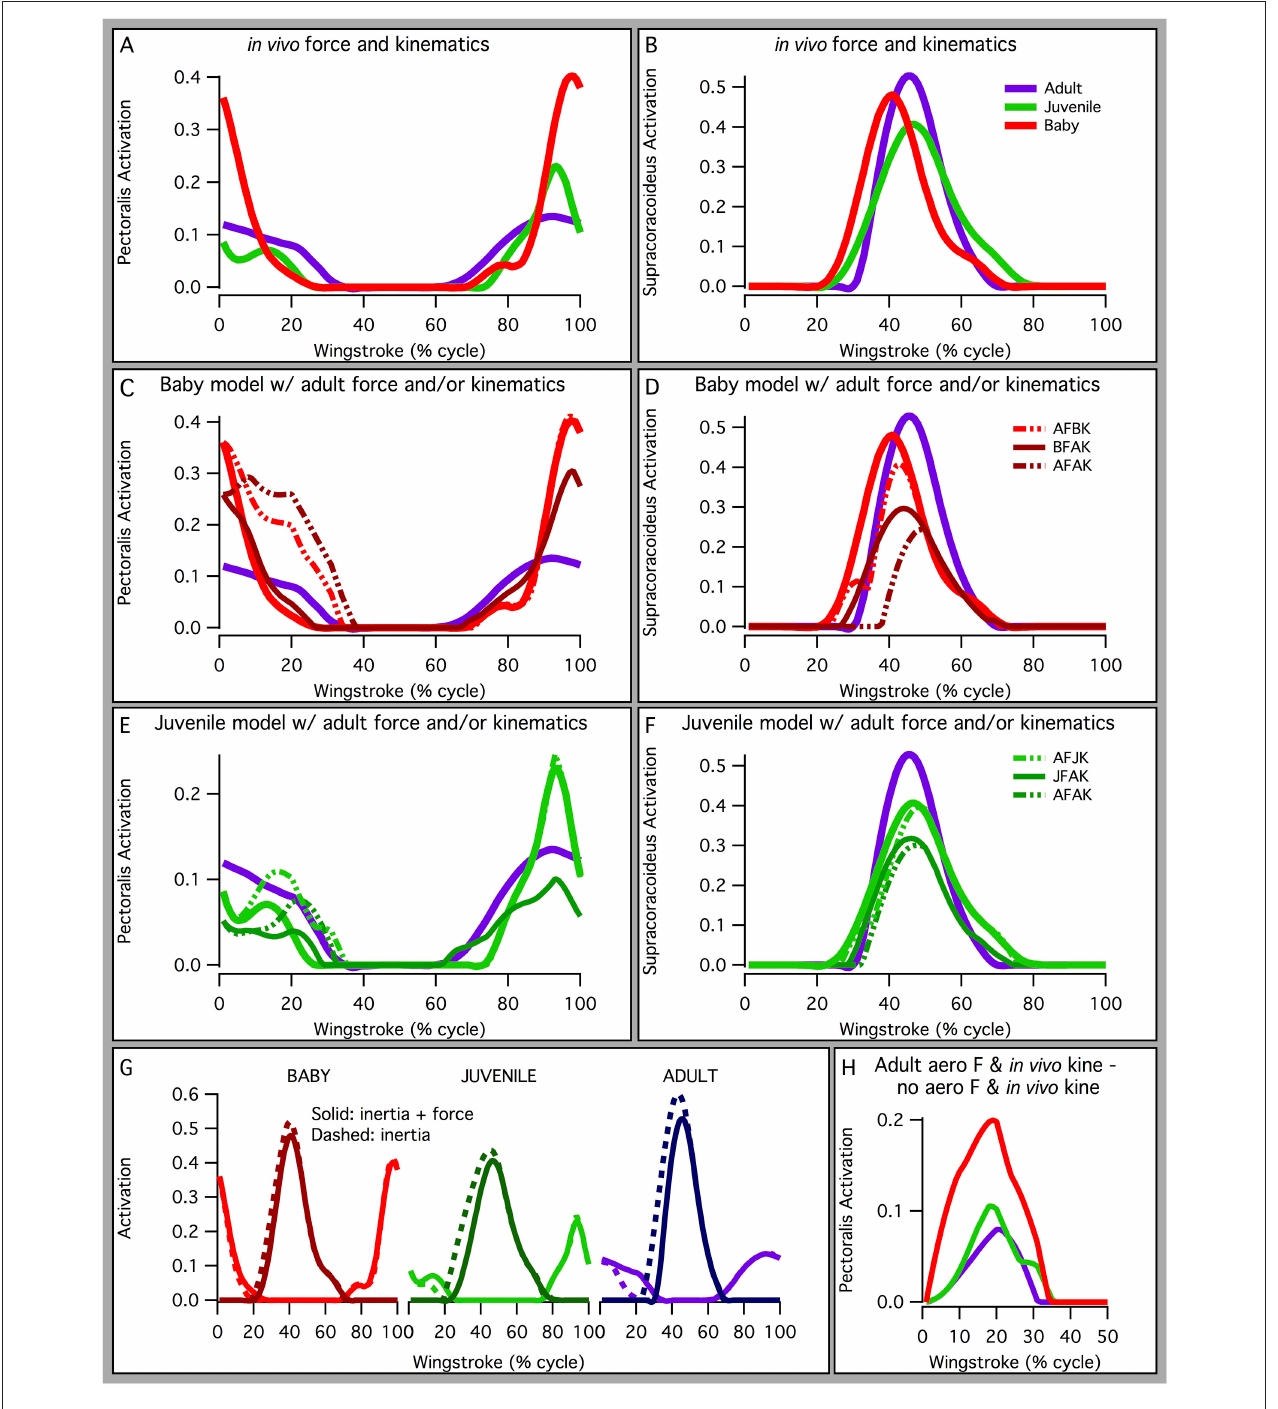
FIGURE 8 | Manipulations in aerodynamic force and kinematics: effects on pectoralis (A,C,E,G,H) and supracoracoideus (B,D,F,G) activation levels. Overall, increasing aerodynamic force production to adult levels (in terms of percent body weight) in the baby and juvenile models increases activation of the pectoralis muscle during mid-downstroke, but not to high levels ( < 0.4, baby; < 0.15, juvenile). Supracoracoideus activation decreases, because increased aerodynamic force production helps decelerate the wing and prepare for upstroke. (A,B) In vivo kinematics and aerodynamic force production; (C–F) baby or juvenile model simulated with different combinations of aerodynamic force (BF, baby force; JF, juvenile force; AF, adult force) and kinematics (BK, baby kinematics; JK, juvenile kinematics; AK, adult kinematics), in vivo activations for adult and baby or juvenile still shown; (G) in vivo kinematics with (solid lines) or without (dashed lines) aerodynamic force production, pectoralis indicated by lighter colors (red, light green, purple), and supracoracoideus by darker colors (maroon, dark green, indigo); (H) activation due to aerodynamic force production: in vivo kinematics with no aerodynamic force production subtracted from in vivo kinematics with adult aerodynamic force production, to account for ontogenetic differences in inertial